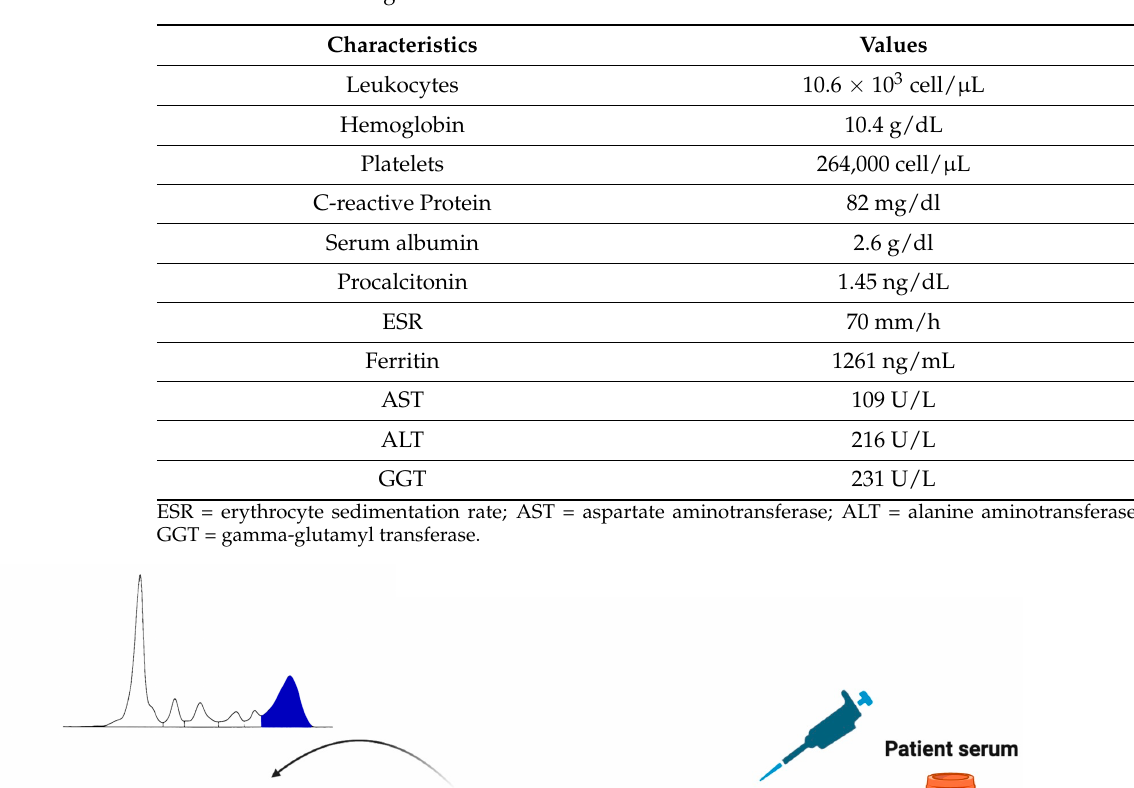
Table 2. Clinical findings at the admitted at the “Guido Baccelli” Unit of Internal Medicine.